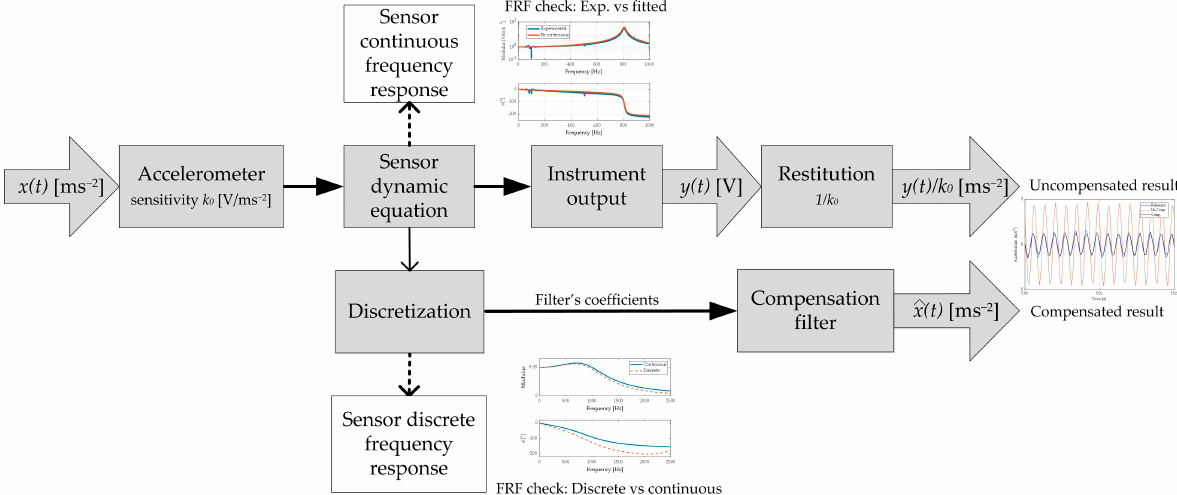
Figure 1. Overall view of the method.